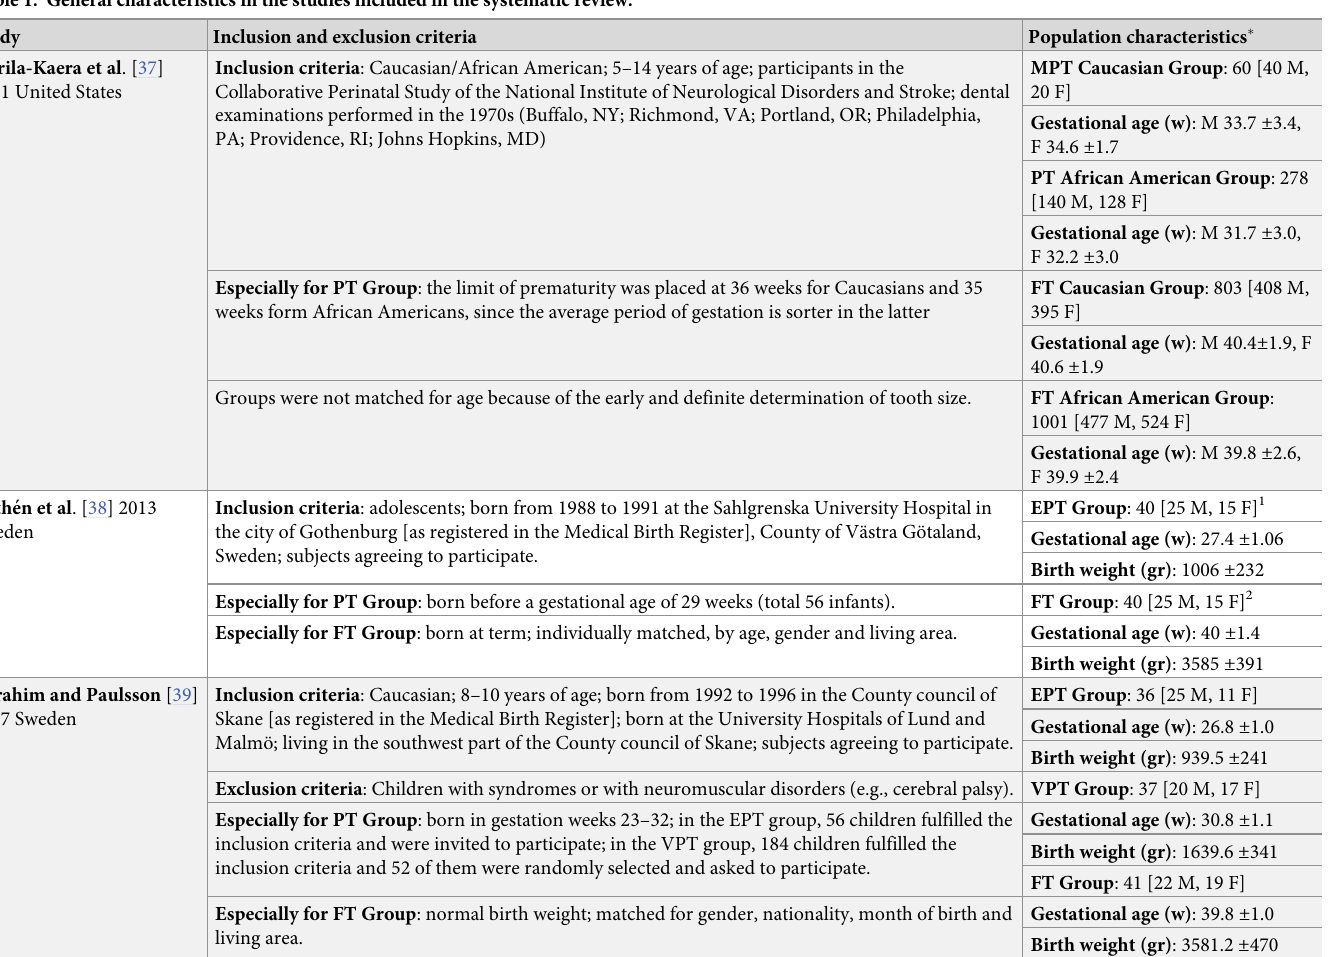
Table 1. General characteristics in the studies included in the systematic